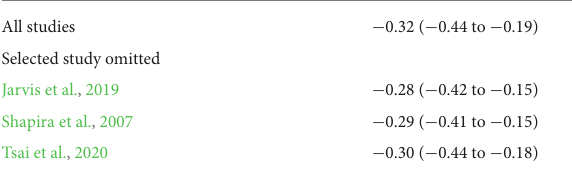
TABLE 2 Sensitivity analysis (omitting a single RCT)*.